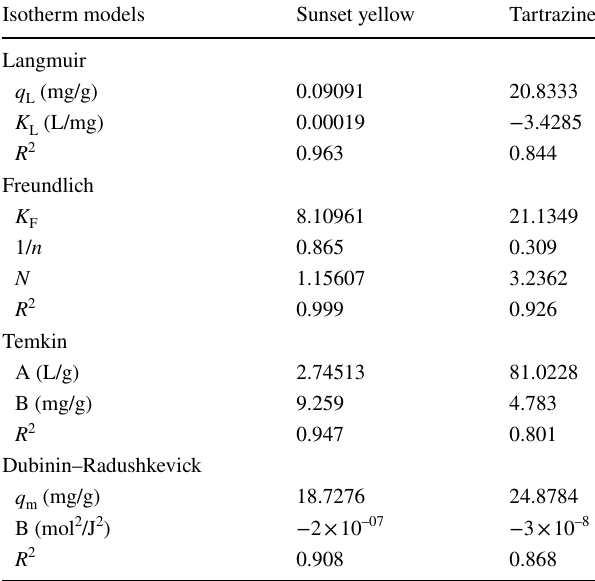
Table 1 Isotherm parameters for the uptake of sunset yellow and tar- trazine onto